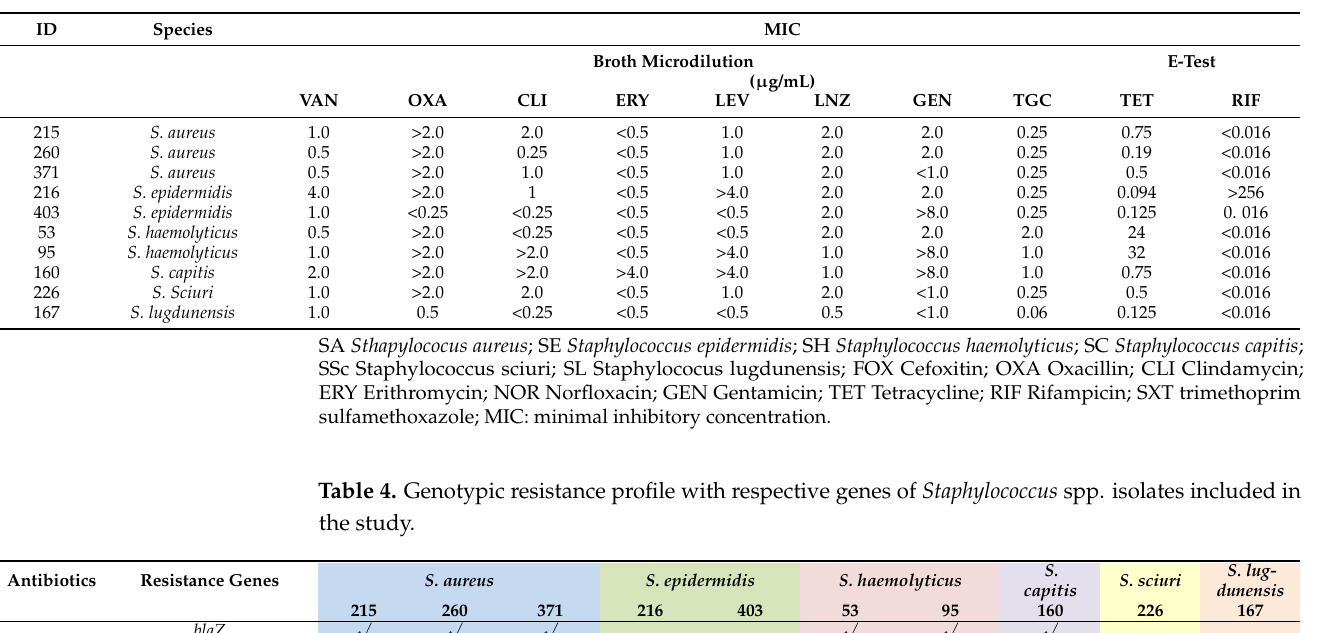
Table 3. Phenotypic resistance profile using disk diffusion test, and broth microdilution and E-test for minimal inhibitory concentration (MIC) characterization of Staphylococcus spp. isolates included in the study.